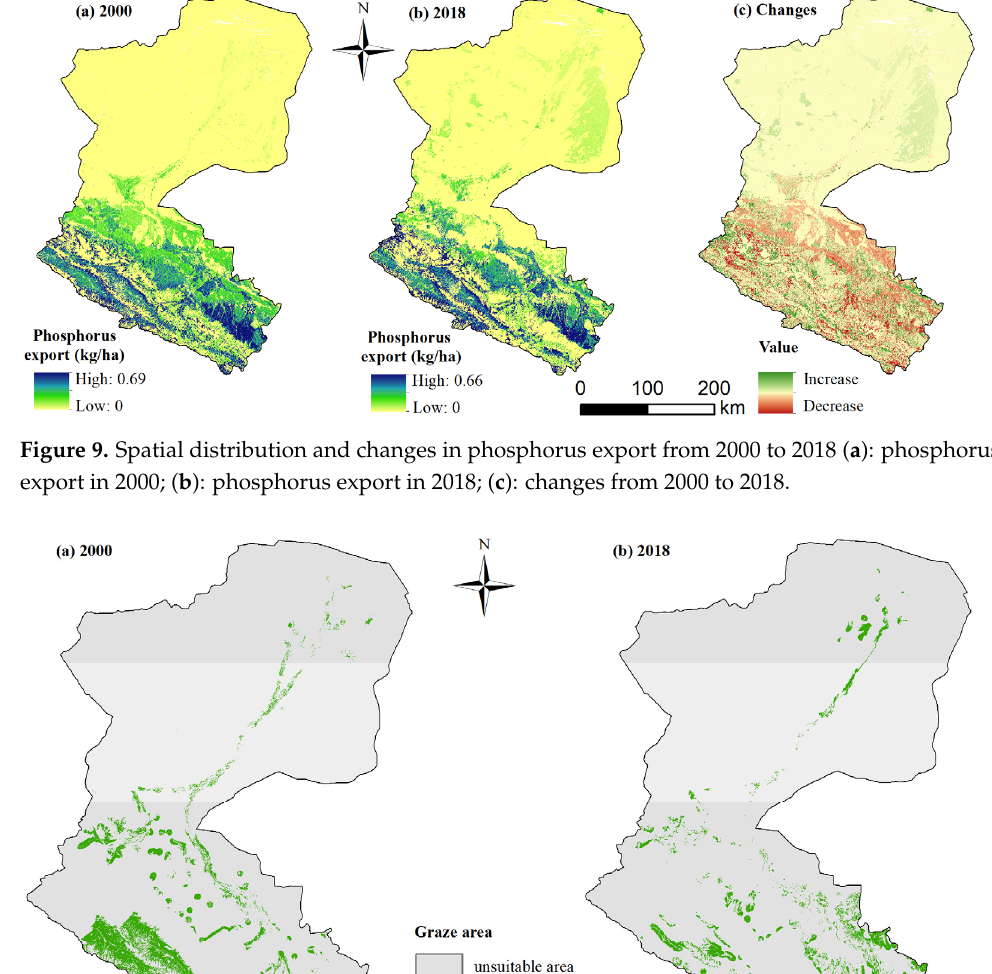
Figure 8. Spatial distribution and changes in nitrogen export from 2000 to 2018 ( a ): nitrogen export in 2000; ( b ): nitrogen export in 2018; ( c ): changes from 2000 to 2018).